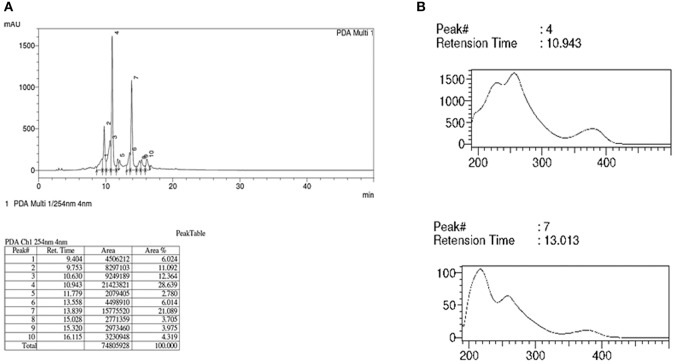
Analysis of LC/DAD and HPLC/DAD data for SF10-FBuOH. (A) The chromatographic profile and a table containing the RTs and areas (%) of peaks detected at 254 nm. HPLC detected 10 peaks in FBuOH, with RTs ranging from 9.404 to 16.115 min. The major peaks were peaks 4 (RT = 10.943 min) and 7 (RT = 13.013 min). (B) The ultraviolet absorption spectra of the major peak was at 4:07.